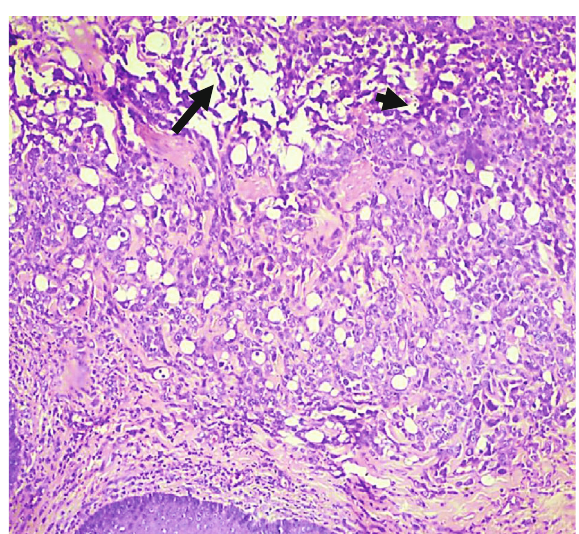
Figure 2: Photomicrograph of the skin (haematoxylin and eosin stain, × 100) showing damaged super fi cial fascia and subcutaneous tissue (arrow), in fi ltrated by necrotic and e ff ete polymorphs and histiocytes (arrowhead) and bacteria.